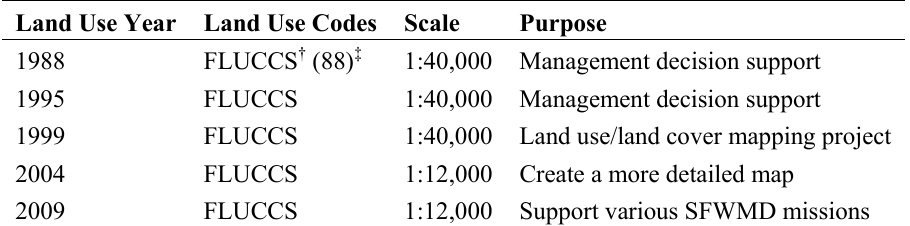
Table 1. Land use data used for land use change